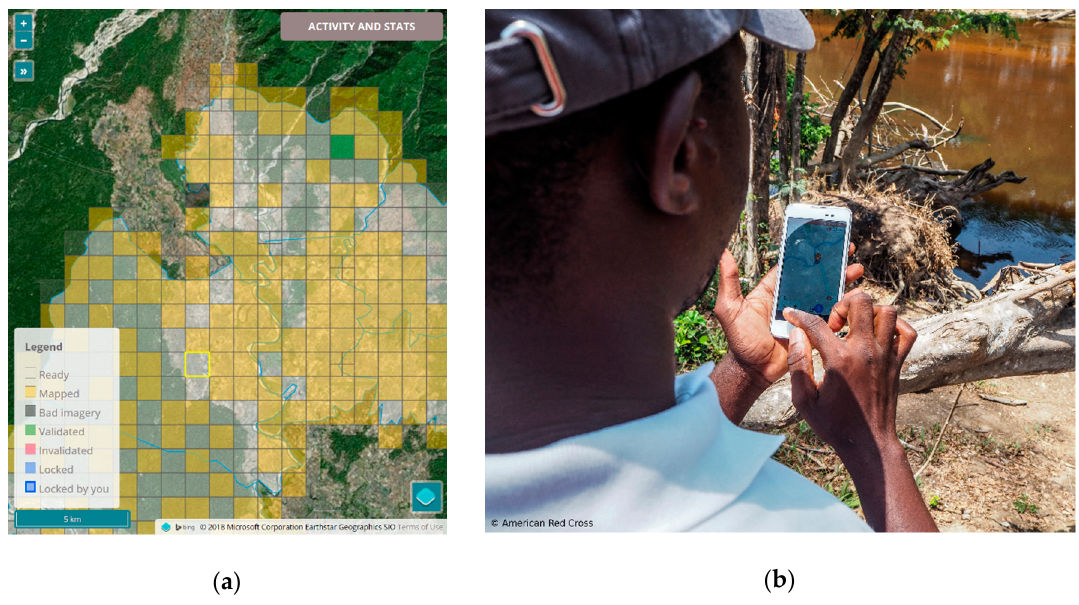
Figure 1. Missing Maps mapping projects are based on deriving volunteered geographic information from remotely sensed imagery. To ensure data quality, validation by local volunteers on the ground is integrated in the mapping workflow: ( a ) An example of a British Red Cross remote mapping project in the HOT Tasking Manager (https://tasks.hotosm.org/project/3677); and ( b ) A Red Cross and Red Crescent Movement volunteer uses an open source, freely accessible mobile application to verify a derived map.